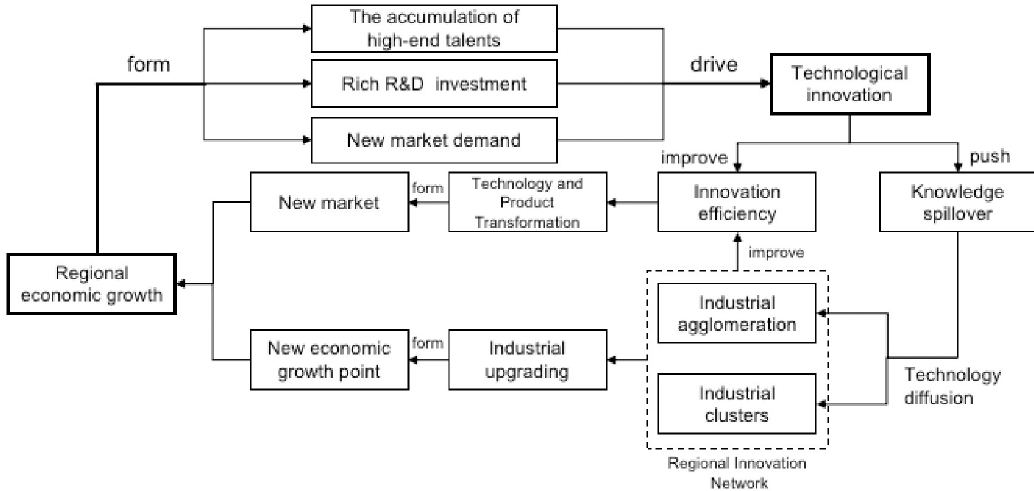
Fig 2. The action path of technological innovation and regional